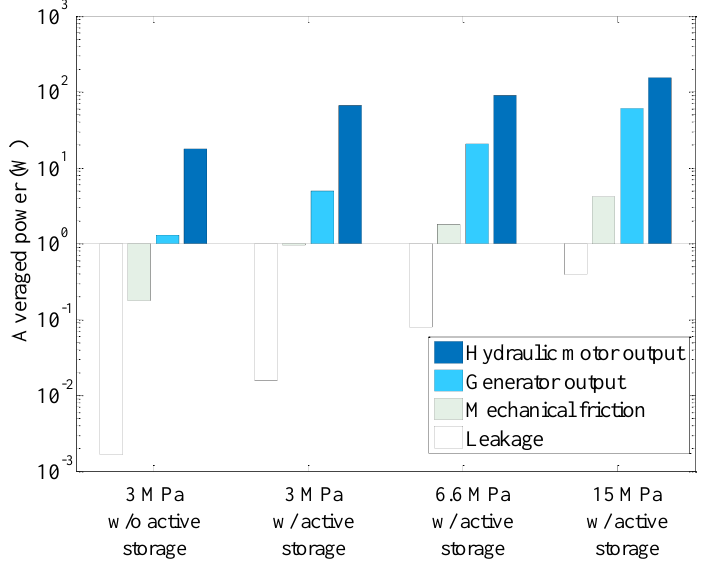
Figure 12. Calculated averaged power of the proposed PTO using experimental data. Note the magnitudes of the averaged power are shown in a semi-logarithmic plot for clarity. The averaged outputs of electrical power for the four cases are 1.3 W, 5.0 W, 20.6 W, and 60.2 W.